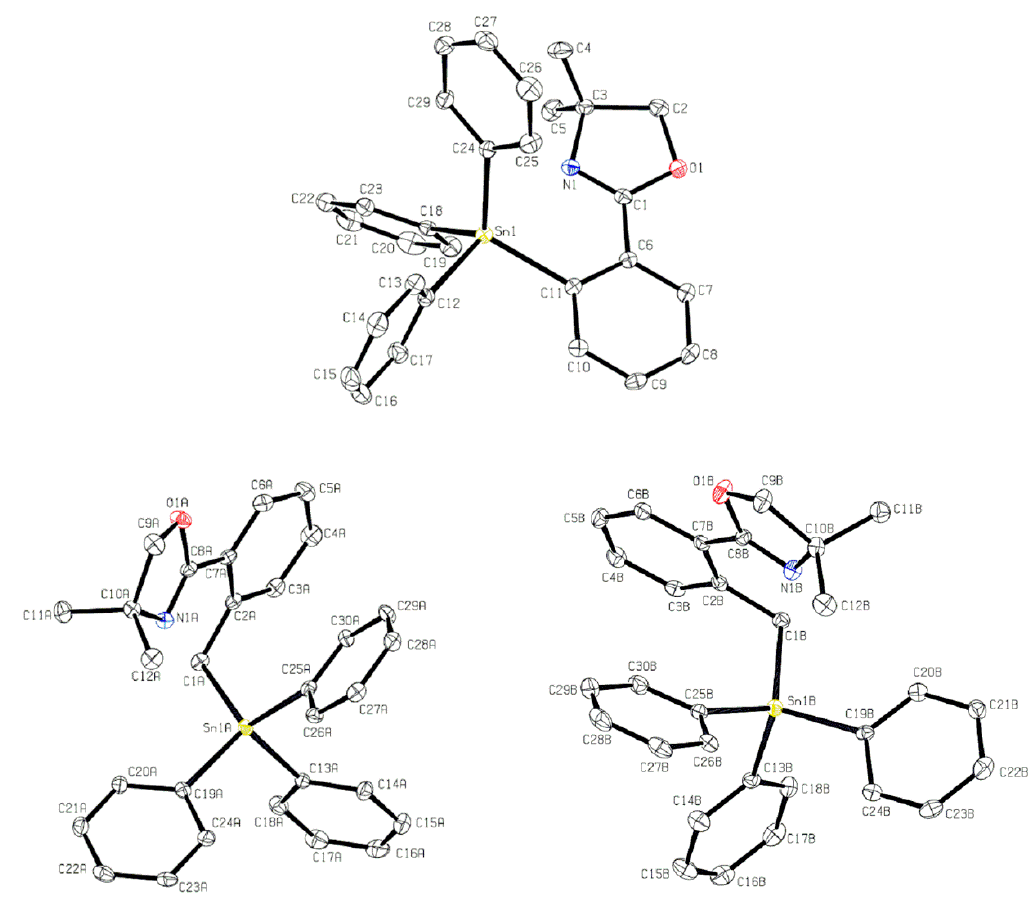
Figure 4. Displacement ellipsoid plots of 7 (top) and the two structurally unique molecules of compound 4 ( 4 ′ : left and 4 ″ : right bottom) found in the unit cell. Thermal ellipsoids shown at the 30% level.